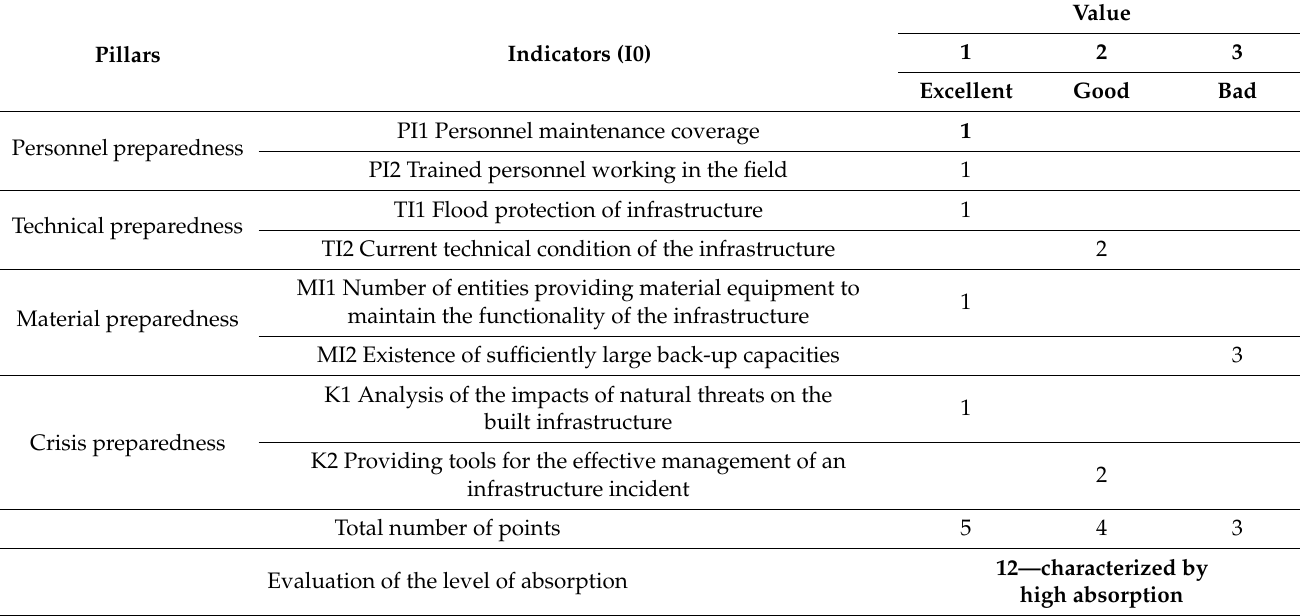
Table 2. Examples of indicators for individual pillars evaluating absorption.